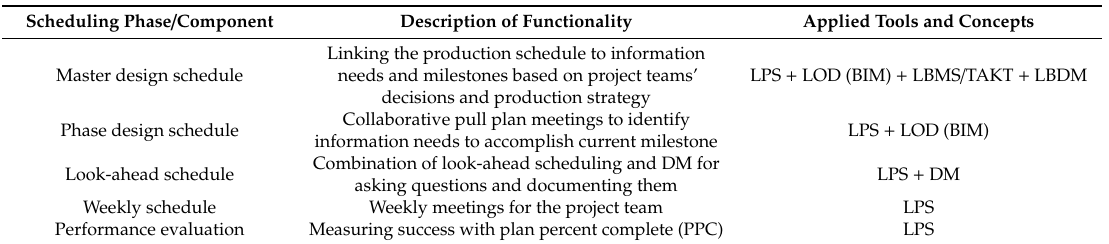
Table 1. Lean design management (LDM) Overall process and its main